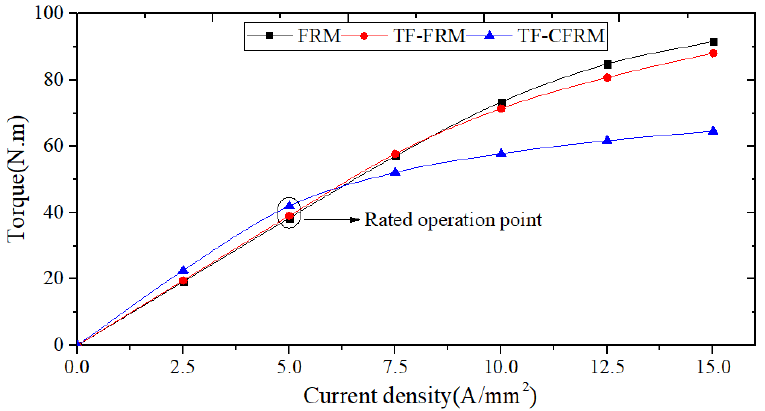
Figure 9. Torque over-load capability comparison among FRM, TF-FRM, and TF-CFRM by